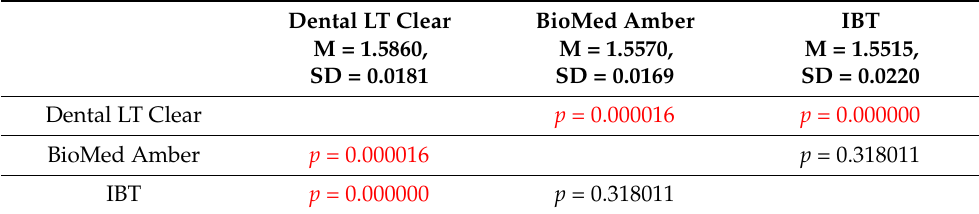
Table 12. Post hoc ANOVA results (least significant difference) for comparing FD values of each material after the compression test (M—mean; SD—standard deviation; p — p -value; the statistical significance for p < 0.05 was presented in